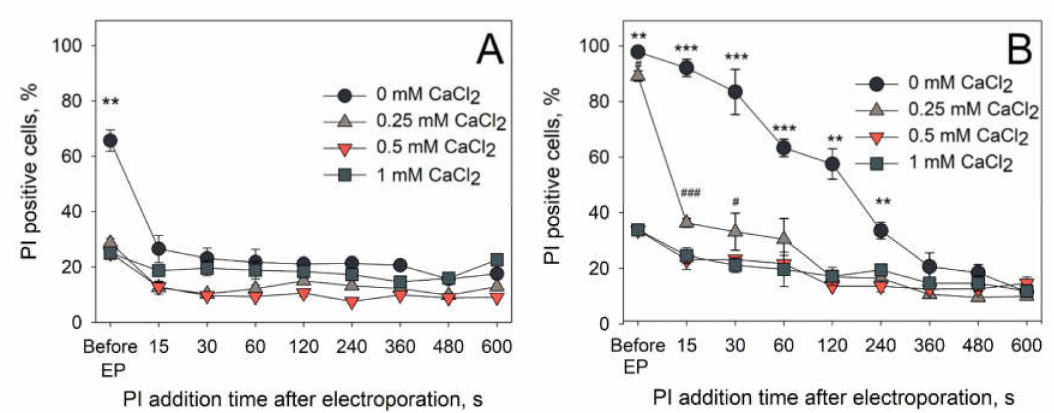
Figure 7. Membrane resealing dynamics after the treatment with a single 1400- ( A ) or 2800-V / cm ( B ) strength, 100- µ s duration HV pulse, monitored by the entry of PI (40 µ M) added 15–600 s after electroporation. Statistical di ff erences between the control (0 mM CaCl 2 concentration) and either of the 0.25, 0.5 or 1 mM CaCl 2 groups are denoted as *, and between 0.25 mM CaCl 2 and either 0.5 or 1 mM CaCl 2 groups are denoted as #. A single symbol denotes two-tailed p < 0.05, double symbol— p < 0.01, and triple symbol— p < 0.001, PI fluorescence was measured 15 min after electric field application. The error bars represent the mean ± standard error of mean of n = 6 experimental